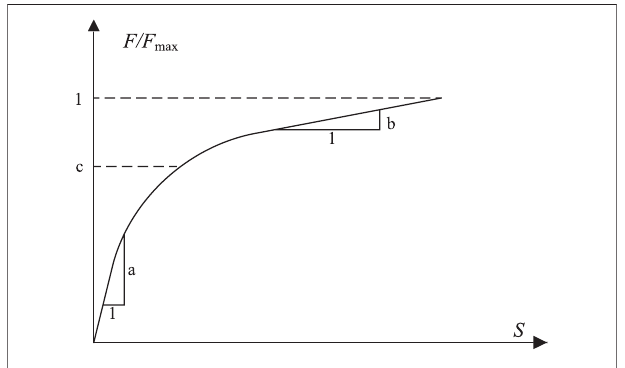
FIGURE 17 | Three-parameter model.